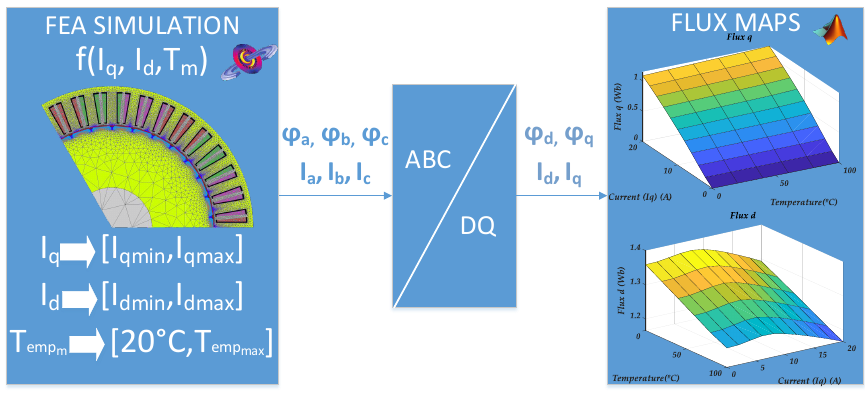
Figure 3. Magnetic flux map generation